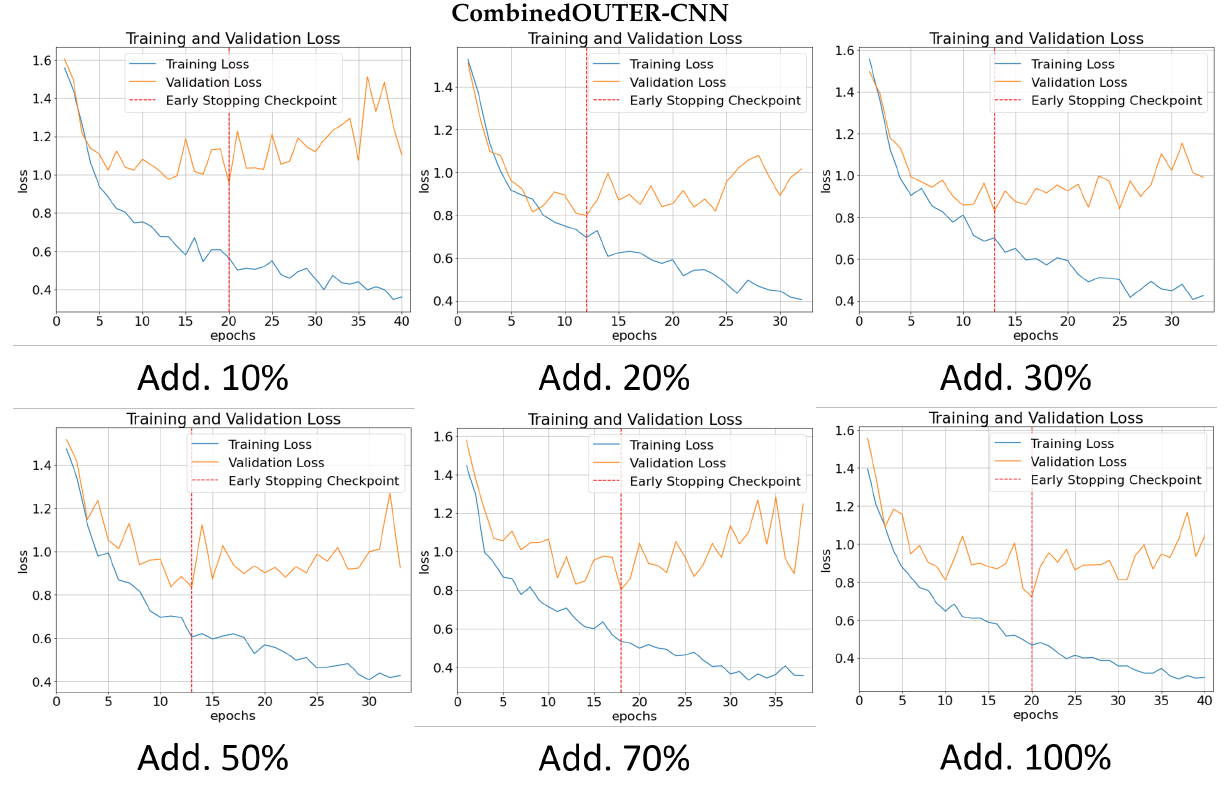
Figure A4. The training and validation losses of the models fed with increments of 10% of additional double-barred beach data with the outer bar